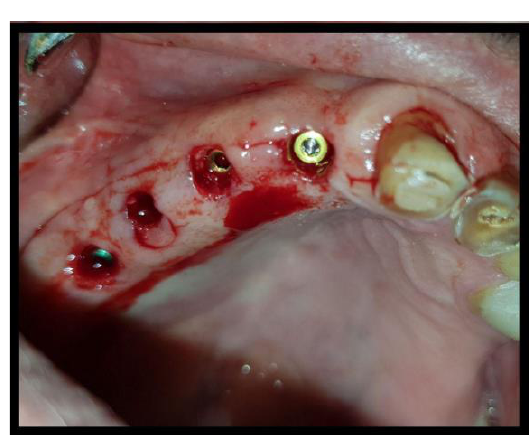
Figure 6: Fixtures after placement in